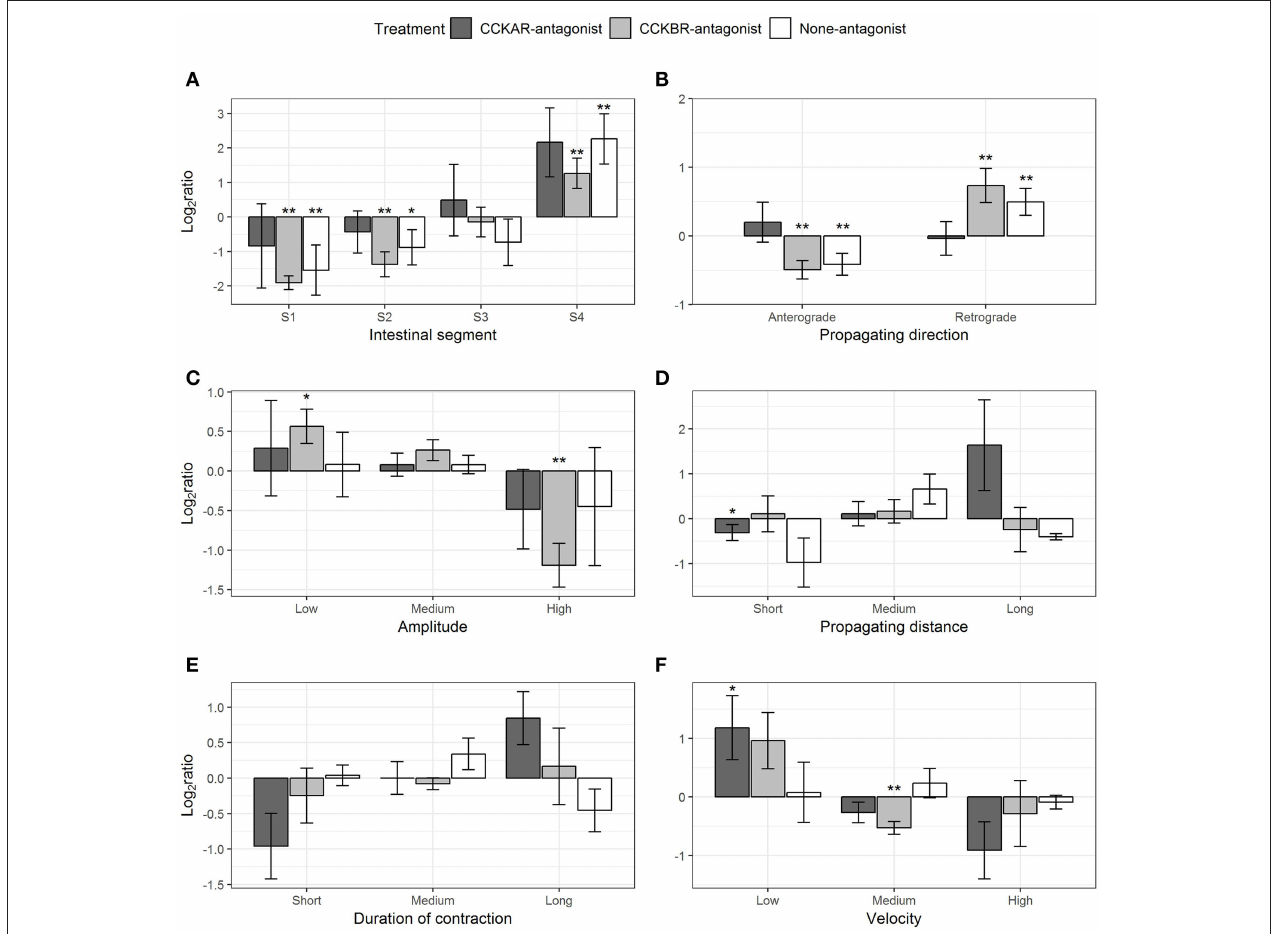
FIGURE 10 | Effect of CCK-8S with presence of CCK-receptor antagonists on ripples. CCKAR-antagonist: intestines were pre-incubated with devazepide, CCKBR-antagonist: intestines were pre-incubated with L-365260, and None-antagonist: intestines were pre-incubated with DMSO as a control prior to exposing intestine to CCK-8S. The six plots show log 2 of ratios of contraction parameters recorded after to before exposing intestine to CCK-8S: (A) for frequency of ripples measured in four intestinal segments (S1, S2, S3, and S4); (B) for proportion of ripples which propagated with an anterograde or retrograde direction; (C) for proportion of ripples which had a low, medium or high amplitude; (D) for proportion of ripples which propagated for a short, medium, or long distance; (E) for proportions of ripples which prolonged for a short, medium, or long duration; (F) for proportion of ripples which propagated at a low, medium or high velocity. Bars are presented with mean ± SEM ( n = 4 for CCKAR-antagonist, n = 5 for each CCKBR-antagonist/none-antagonist). Asterisk (*) denotes the statistically significant differences of ratio values compared with 0 (one sample t -test, * for 0.05 ≤ p < 0.1 and ** p <